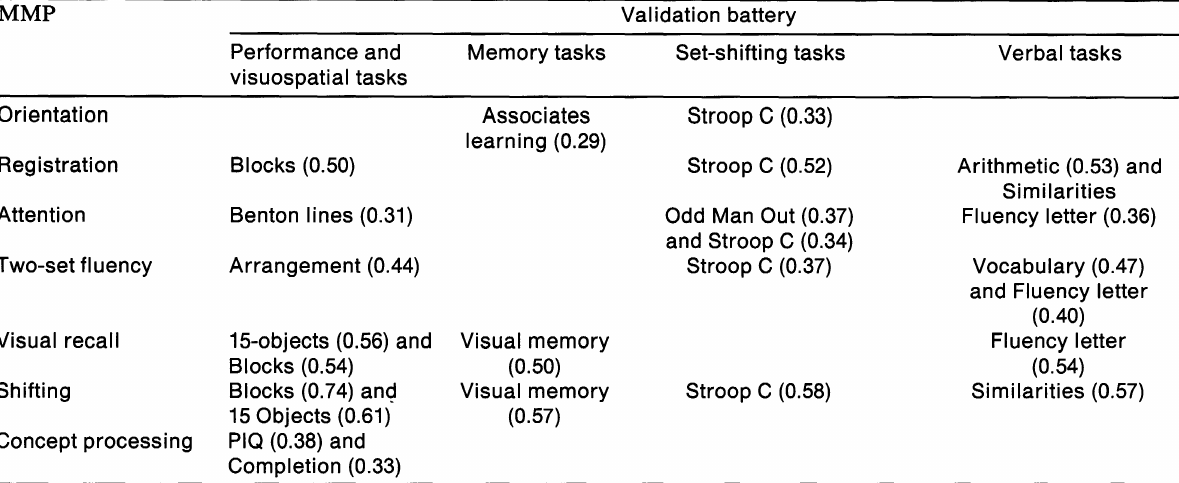
TABLE V. Content validity. Correlation coefficients of each subsection of the MMP with the validation battery (Spearman's rank coefficient): the highest (statistically significant) coefficients